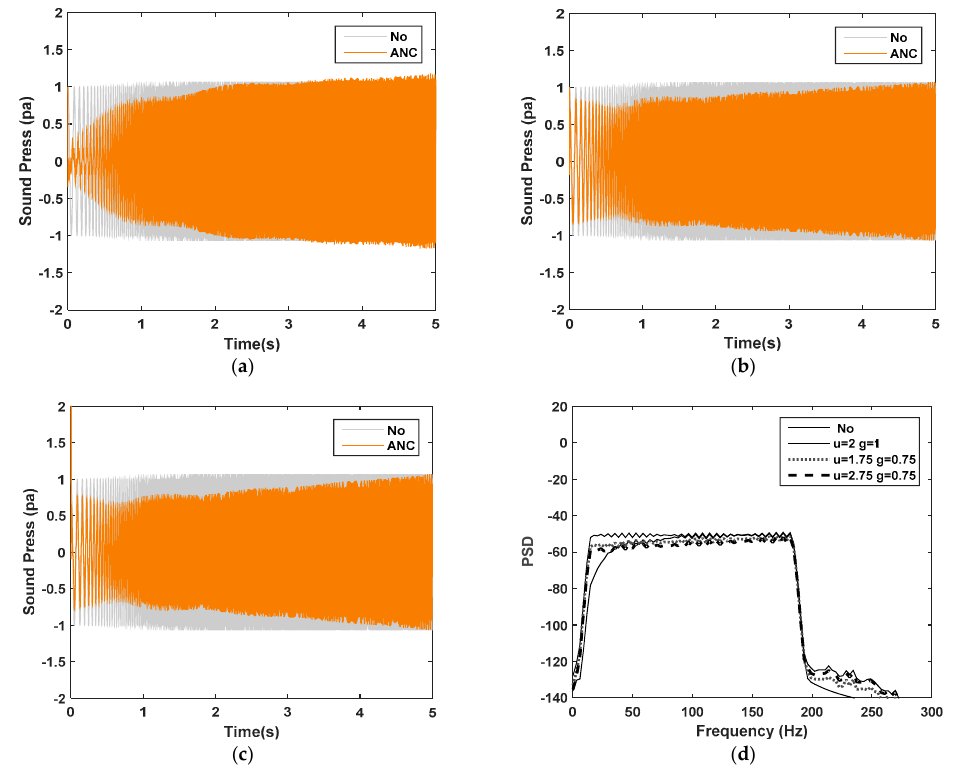
Figure 7. Time history and PSD of signal 1 controlled by the NLMS algorithm-based adaptive notch filter with two weights ( L = 2) ( a ) Time history ( µ = 2, γ = 1); ( b ) Time history ( µ = 1.75, γ = 0.75); and ( c ) Time history ( µ = 2.75, γ = 0.75) and ( d ) PSD.